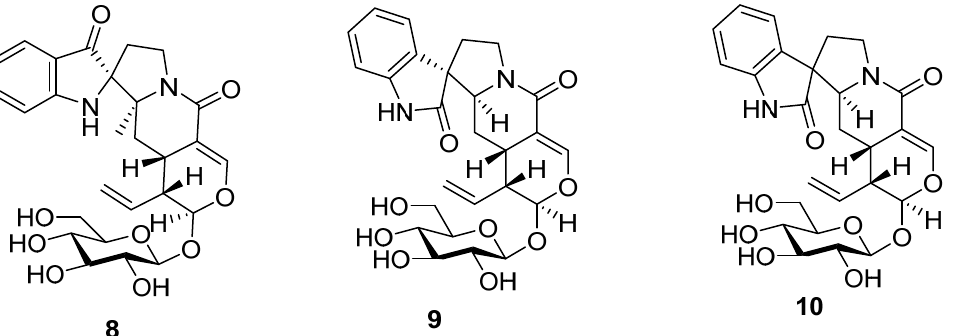
Figure 5. Spirooxindoles (2S,3S)-javaniside 8 , naucleoxoside A 9 , and naucleoxoside B 10 isolated from the stem of Nauclea officinalis .